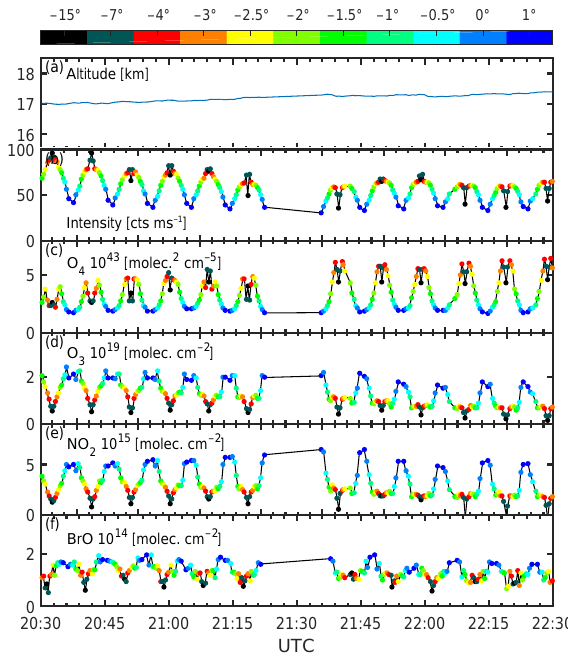
Figure 4. Overview of a 2h segment of SF3-2013 (14 February 2013) with varying cloud cover: 20:30–20:45UT clouds between 11 and 12km; 20:45–21:10UT clouds between 7 and 9km; 21:45– 22:15UT few clouds between 1 and 2km altitude. The different colors denote different elevation angles (see color scale at the top). Intensity, O 4 , O 3 , and NO 2 DSCD were derived in the VIS wave- length range, while the BrO DSCD was retrieved in the